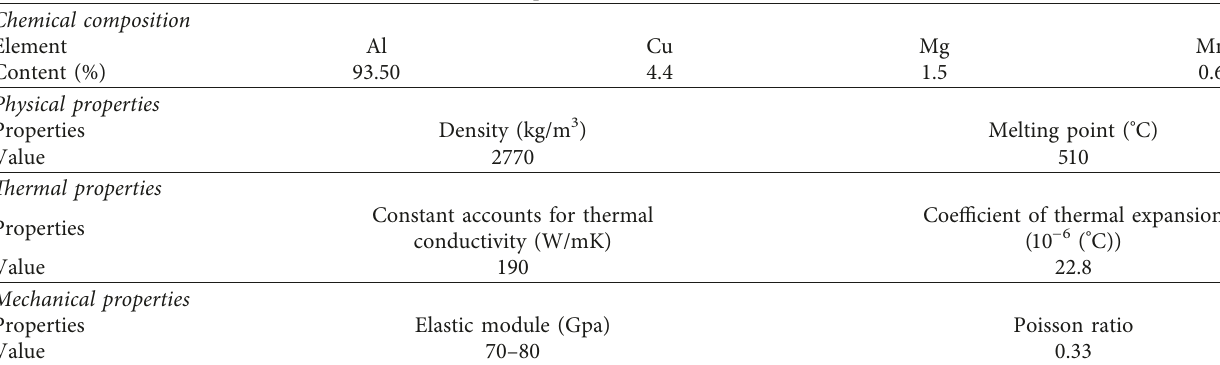
Table 1: Properties of base metal Al